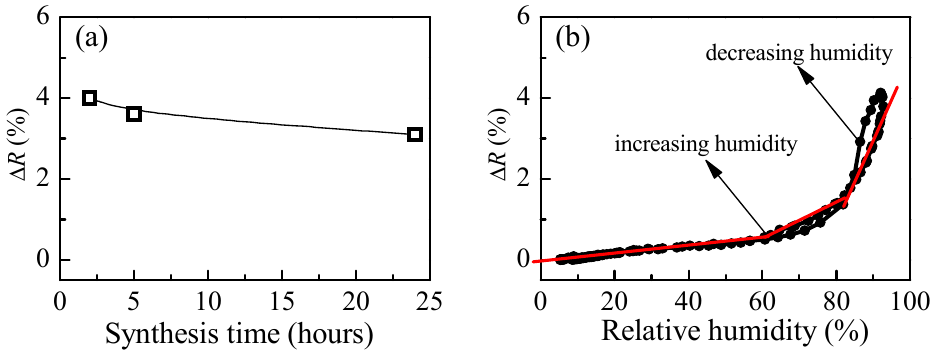
Figure 8. ( a ) Reflectance change, Δ R, due to a change of relative humidity from 5%RH to 95%RH as a function of synthesis time for P4 films; and ( b ) variation of reflectance with humidity for P4 thin films.